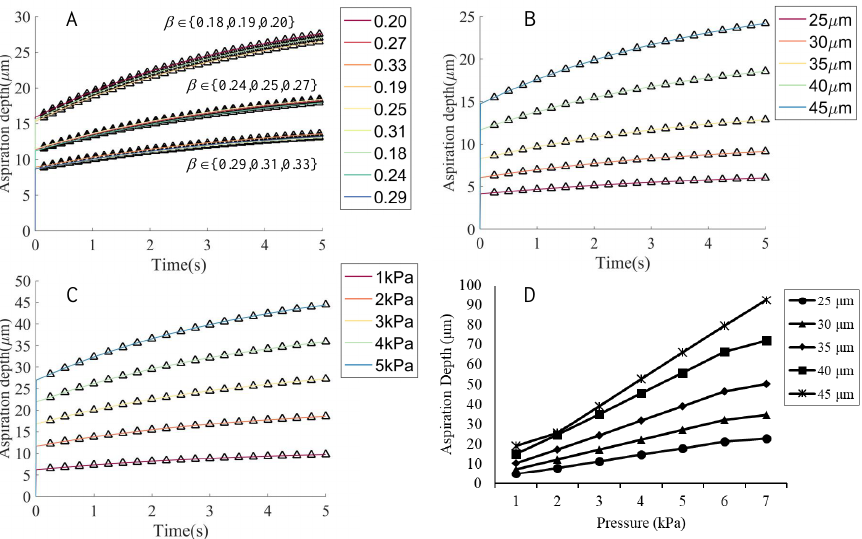
Figure 7. The effects of the ZP thickness, the radius of micropipette, and the aspiration pressure on the aspiration length in the simulation with the ZP and cytoplasm model. ( A ) The variation in the ZP thickness. We defined the parameter β = h / R , where h = 15, 20 or 25 µ m and R = 75, 80 or 85 µ m. The β varied from 0.18 (15/85) to 0.33 (25/75). For the larger ZP thicknesses, the cells appeared to be more rigid and showed less apparent viscoelastic behavior. As h = R , i.e., the case of the homogeneous model, it exhibited approximately elastic behavior (Figure 6). ( B , C ) The variation in the micropipette radius and aspiration pressure. The larger micropipette radii and pressure values induced larger instantaneous deformations and more apparent viscoelastic behavior, because more cytoplasm was involved in the process. ( D ) The changes of aspiration length with the pressure. An approximately linear relationship was observed for the aspiration length vs. the pressure. The cells reacted strongly using a micropipette with a large radius under large